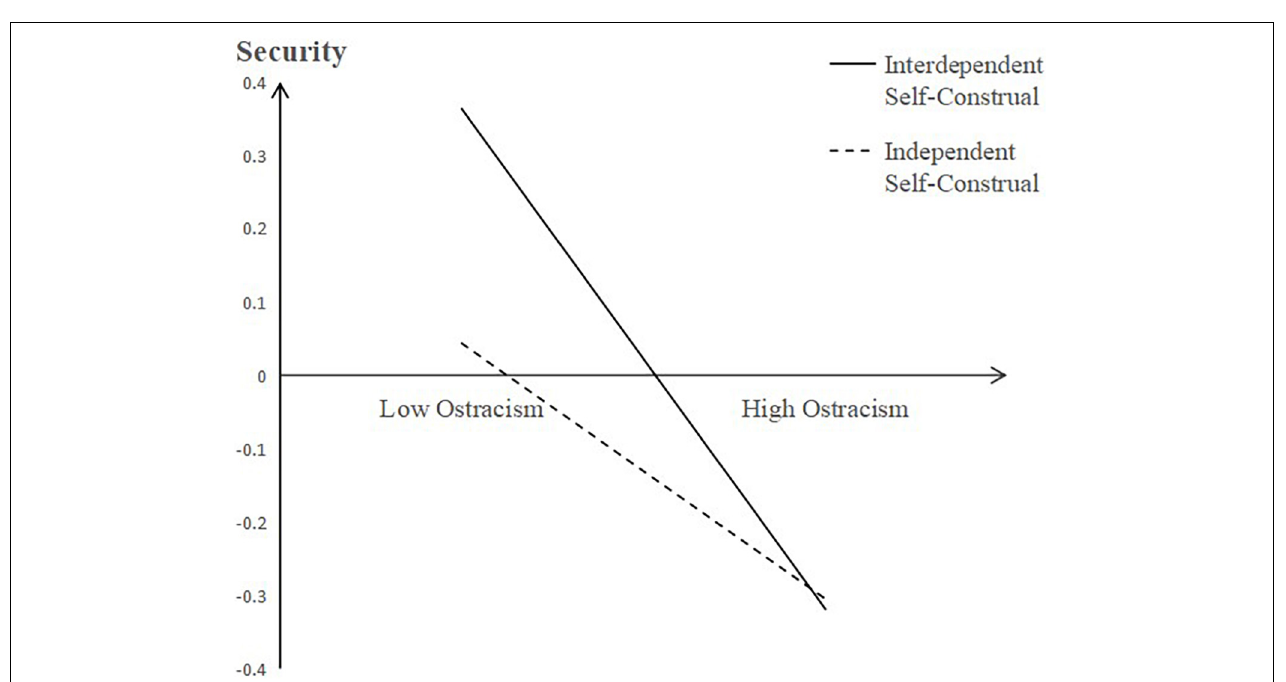
FIGURE 2 | Self-construal as a moderator in the relationship between ostracism and security.